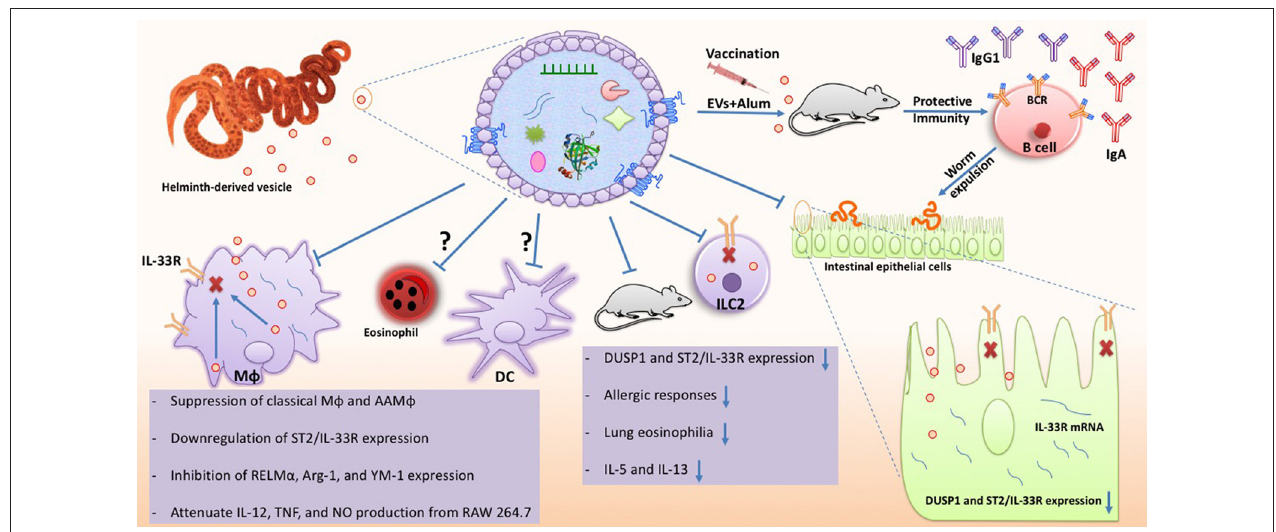
FIGURE 3 | Schematic illustration of known effects imposed by helminth-derived EVs during interaction with host immunity. As illustrated here, EVs can affect different host cells including immune cells and intestinal epithelial cells (IECs). Also, they can potentially be used to develop new vaccines against helminths. EVs deliver cargo containing various biomolecules to host cells which can interfere with host cell gene transcription. EVs are internalized by macrophages and IECs via unknown mechanism and target IL-33R and DUSP1 expression reducing signal transmission and leads to inhibition of helminth expulsion. EVs have also shown great potential in priming host immunity along with Alum as a vaccine complex against helminth infections. Effective suppression of both classical M φ and AAM φ have also been reported, implying EVs are well-equipped with a wide range of active components. In addition to in vitro studies, immunomodulatory functions of EVs have also been monitored in in vivo model in which allergic responses, associated cytokines, ILC2, and eosinophilia are down-regulated in Alternaria-exposed